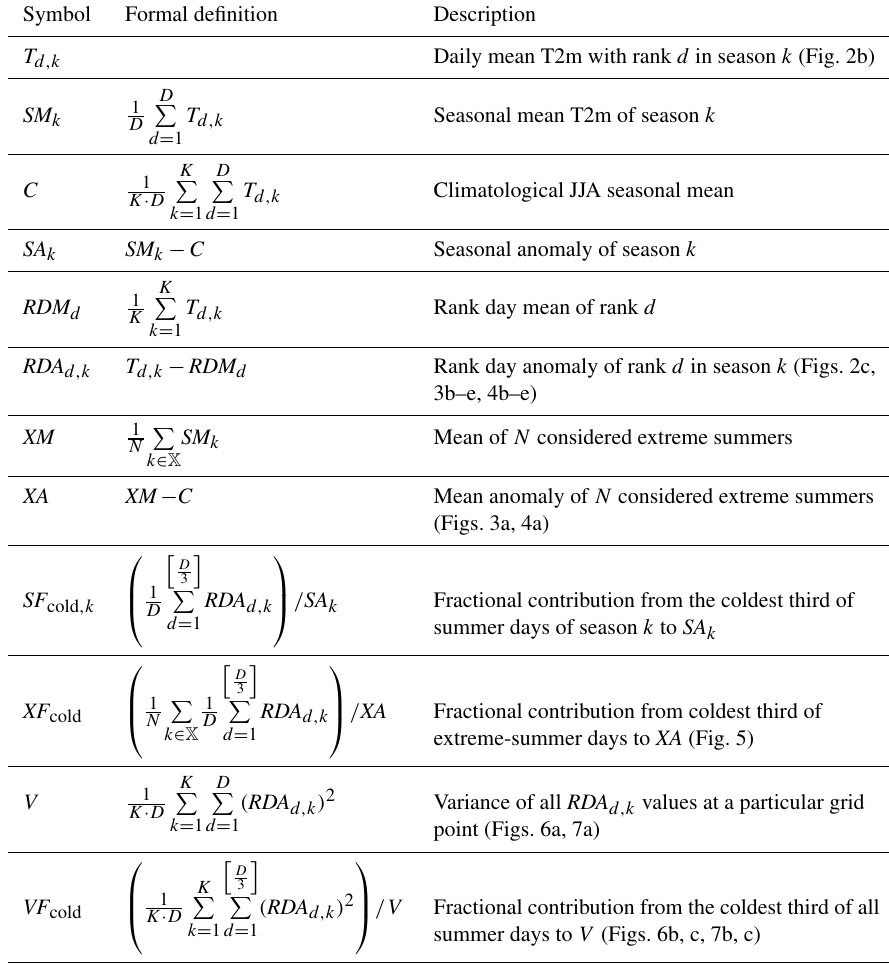
Table 1. Definitions and descriptions of important quantities used in this study. Symbol Formal